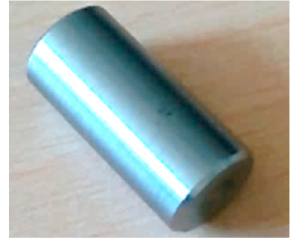
Figure 6. A tested cylindrical sample.